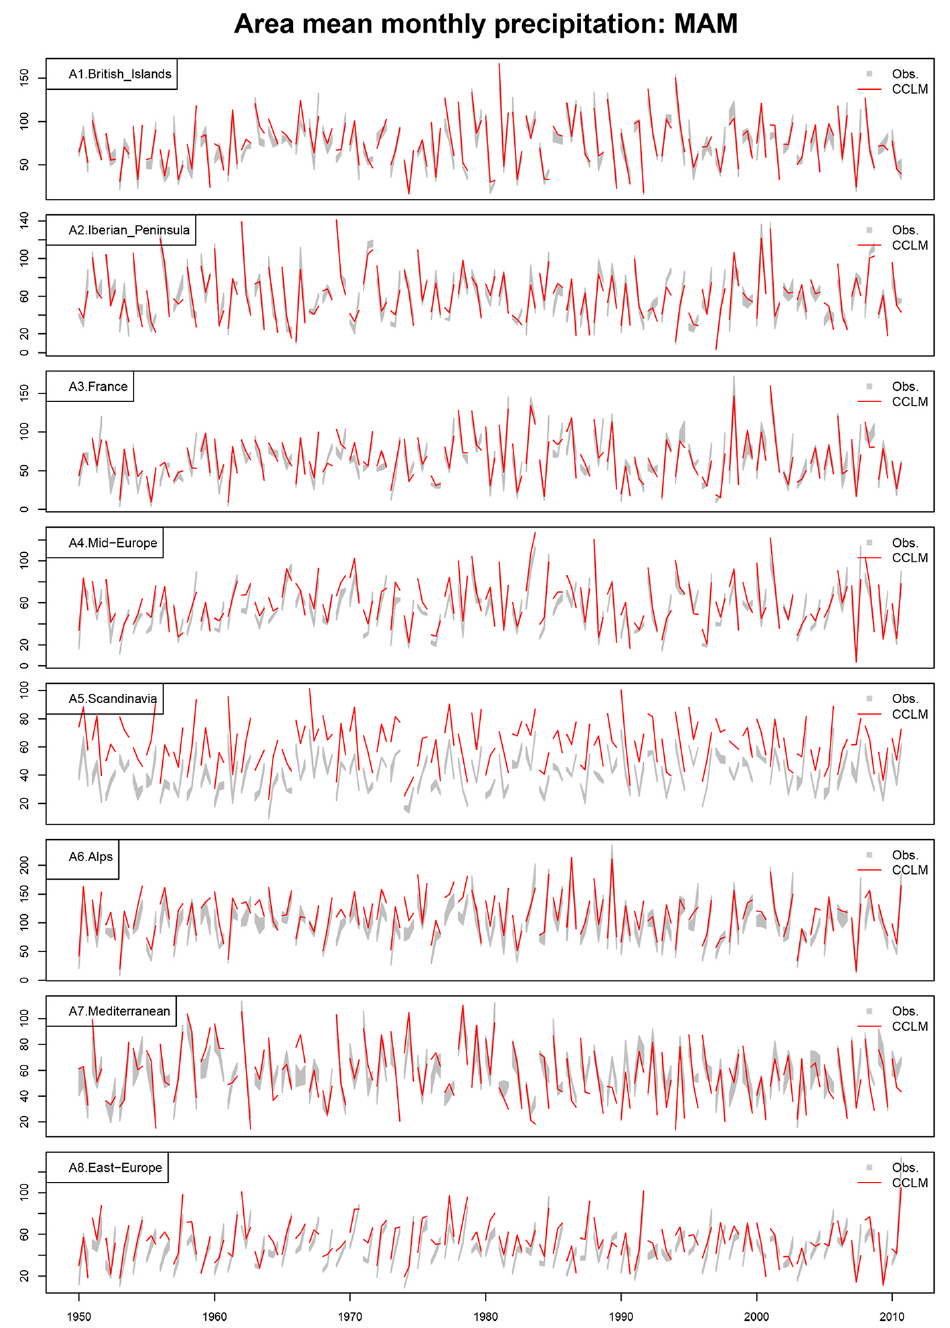
Figure 8b. Area mean monthly sums of total precipitation of March, April, and May of 1950–2010: coastDat2-CCLM (red), range of GPCC6, E-OBS8.0 and CRU3.2 for each season (gray